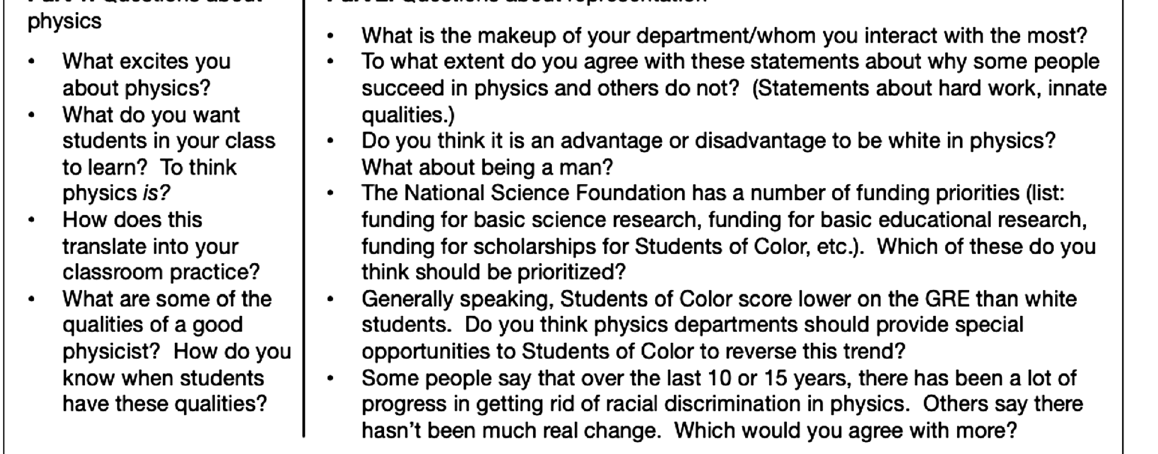
FIG. 2. Sample interview protocol questions (version 1). Image description: Box with a vertical line separating two blocks of bulleted text. To the left of the line is the title, “ Part 1: Questions about physics ” . Bulleted text under the title is a list of questions. The first bullet reads, “ What excites you about physics? ” The second bullet reads, “ What do you want students in your class to learn? To think physics is? ” The third bullet reads, “ How does this translate into your classroom practice? ” The fourth and final bullet reads, “ What are some of the qualities of a good physicist? How do you know when students have these qualities? ” To the right of the vertical line in the box is the title, “ Part 2: Questions about representation ” . Bulleted text under this title is also a list of bulleted questions. The first bullet in this list reads, “ What is the makeup of your department/whom you interact with the most? ” The second bullet reads, “ To what extent do you agree with these statements about why some people succeed in physics and others do not? (Statements about hard work, innate qualities.) ” The third bullet reads, “ Do you think it is an advantage or disadvantage to be white in physics? What about being a man? ” The fourth bullet reads, “ The National Science Foundation has a number of funding priorities (list: funding for basic science research, funding for basic educational research, funding for scholarships for Students of Color, etc.). Which of these do you think should be prioritized? ” The fifth bullet reads, “ Generally speaking, Students of Color score lower on the GRE than white students. Do you think physics departments should provide special opportunities to Students of Color to reverse this trend? ” The sixth and final bullet reads, “ Some people say that over the last 10 or 15 years, there has been a lot of progress in getting rid of racial discrimination in physics. Others say there hasn ’ t been much real change. Which would you agree with more?